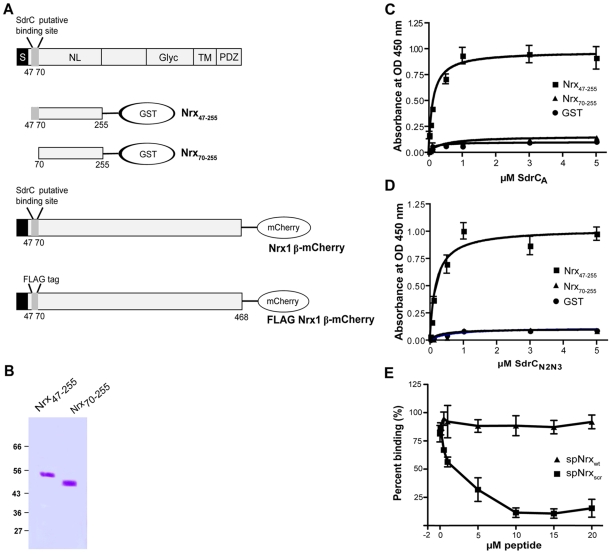
Structural organization of β-neurexins.(A) A cartoon representation of β-neurexin domain structure. S, signal sequence; NL, neuroligin-binding domain; Glyc, glycosylation domain; TM, transmembrane domain; PDZ, intracellular signaling domain. Also shown, are the recombinant proteins used in this study. (B) Coomassie-stained SDS-PAGE gel of GST-tagged neurexin 1β domains recombinant proteins. Increasing concentrations of SdrCA (C) and SdrCN2N3 (D) were incubated with immobilized Nrx47-255 (black square), Nrx70–255 (black triangle) or GST (black circle) for 1 hour at room temperature. The apparent KD (concentrations required for half maximum binding) values were 1.85±0.94×10−7 M for SdrCA and 1.26±0.28×10−7 M for SdrCN2N3. (E) SdrC178–496 (0.5 µM) was incubated with increasing concentrations of spNrxwt peptide (black square) or spNrxscr peptide (black triangle) at room temperature. After 2 hours, the mixture was incubated with immobilized Nrx47–255. The values represented here are the mean±SD of triplicates from three experiments.